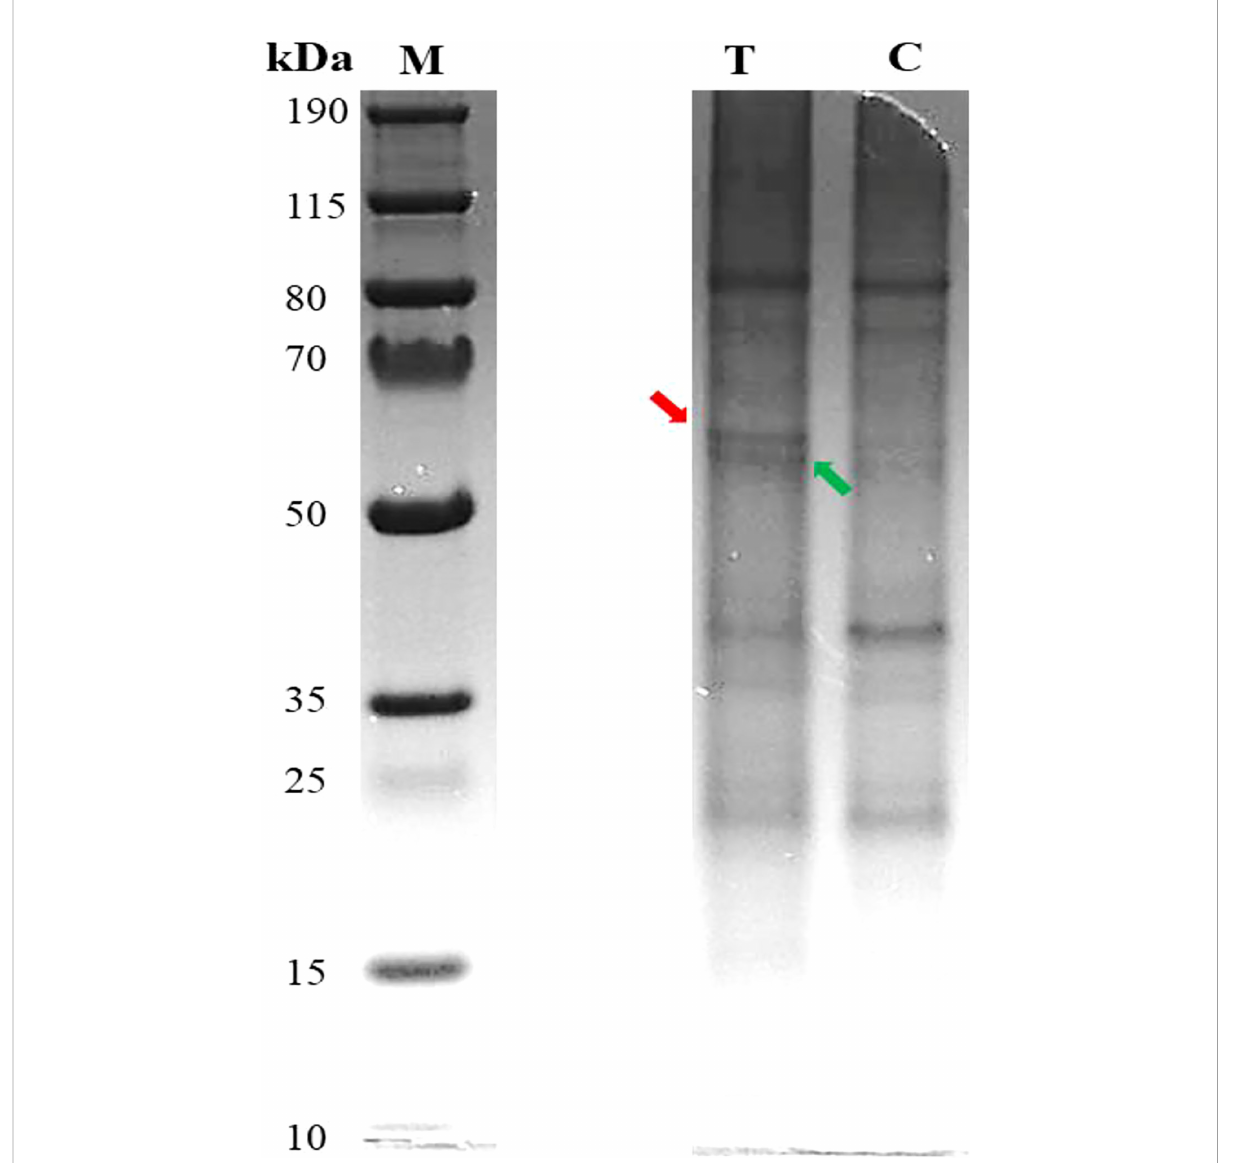
FIGURE 1 Pb-treated T. qataranse SDS-PAGE-separated proteins (whole plant). Lane 1, protein marker; lane 2, treatment (50 mg kg ⎯ 1 Pb); and lane 3, control (0 mg kg ⎯ 1 Pb). Approximately 20 µg of proteins was resolved using NuPAGE 4% – 12% Bis-Tris Gels (Invitrogen) and visualized by Imperial ™ Protein Stain. The fi gure shows that marker (M), treatment (T), and control (C) lanes were excised from the same original gel representing the loading concentration reported in this